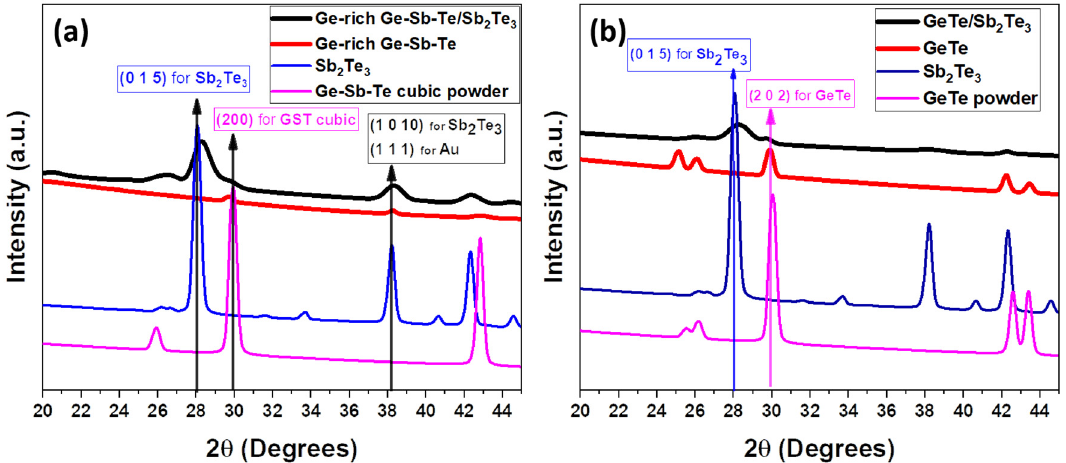
Figure 2. XRD patterns of ( a ) GGST, and GGST/ST core-shell NWs; ( b ) GT, and GT/ST core-shell NWs.